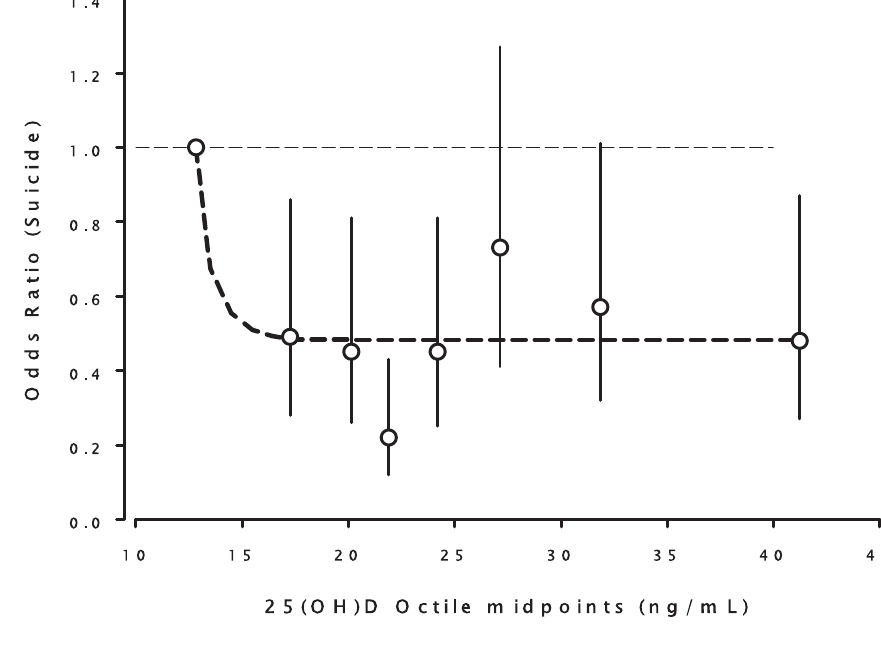
Figure 1. Plot of the computed odds ratios (OR) for the 8 octiles of 25(OH)D concentration, locating each at the mid-point of the respective octiles. The vertical lines at each point represent the 95% confidence intervals for each odds ratio, (see Table 2, footnote 1). The dashed line is the least squares fit of the 8 values to the equation: OR=0.48 + 10,220 exp ( 2 0.9893X), which is the expression best suited to describe nutrient effect as a function of intake. As is visually apparent, the regression line falls within the confidence limits for 6 of the 7 octiles above the first. (Copyright, Robert P. Heaney, 2012. Used with permission.).